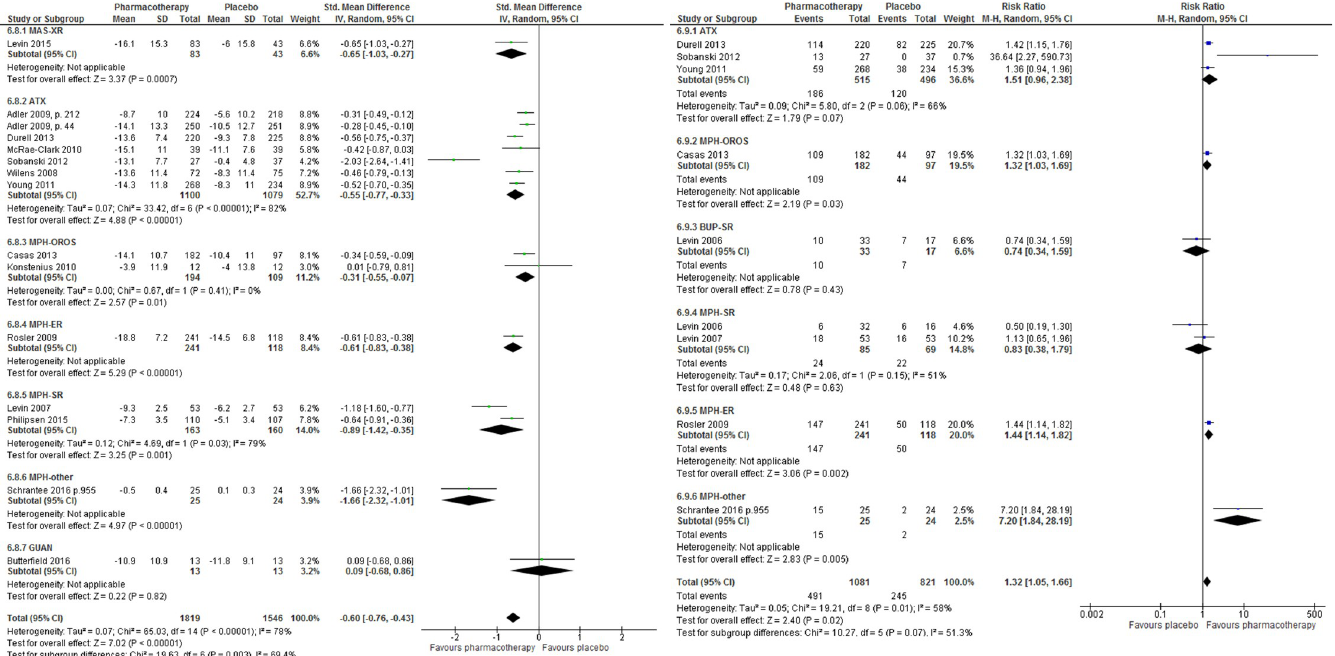
Fig 5. Clinician-reported clinical response. Clinical response among patients who received any ADHD pharmacotherapy (versus placebo) in trials with a treatment duration of at least 12 weeks. (A) Continuous measure of response. (B) Dichotomous (treatment response: yes versus no).